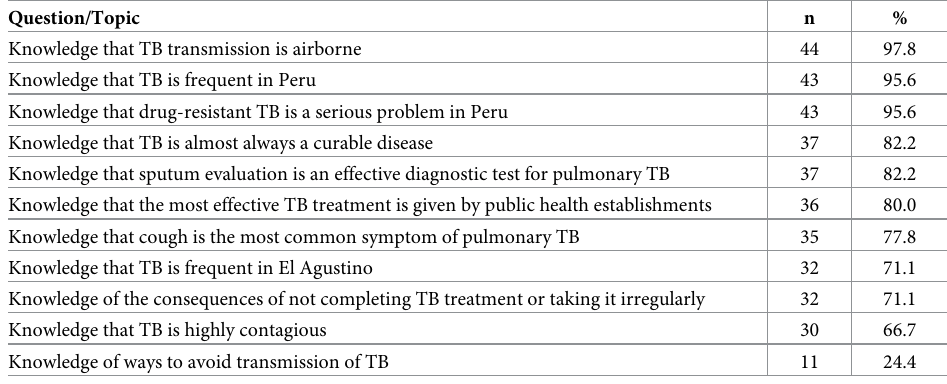
Table 2. Participants’ TB-related knowledge as demonstrated by the percentage of correct answers per question, pharmacy workers, El Agustino, Lima, Peru (N = 45). Question/Topic n